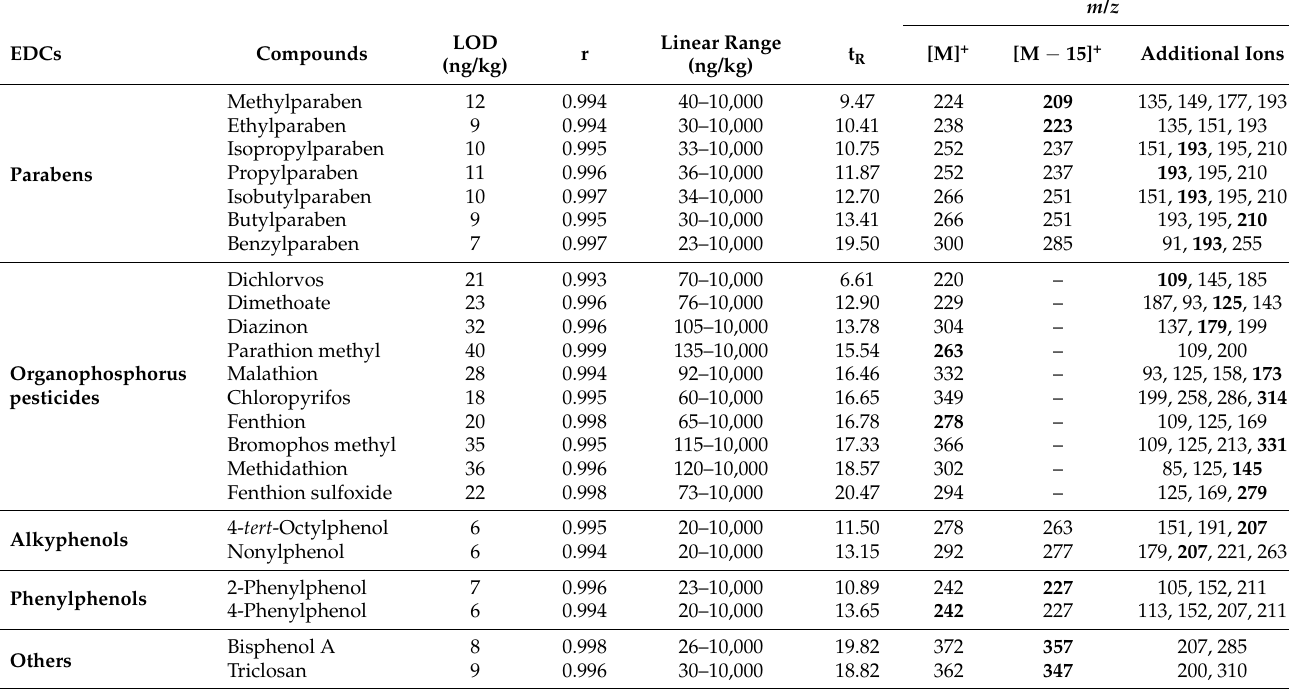
Table 1. Analytical figures of the determination of EDCs in milk and dairy products by the proposed SPE–GC–MS method a